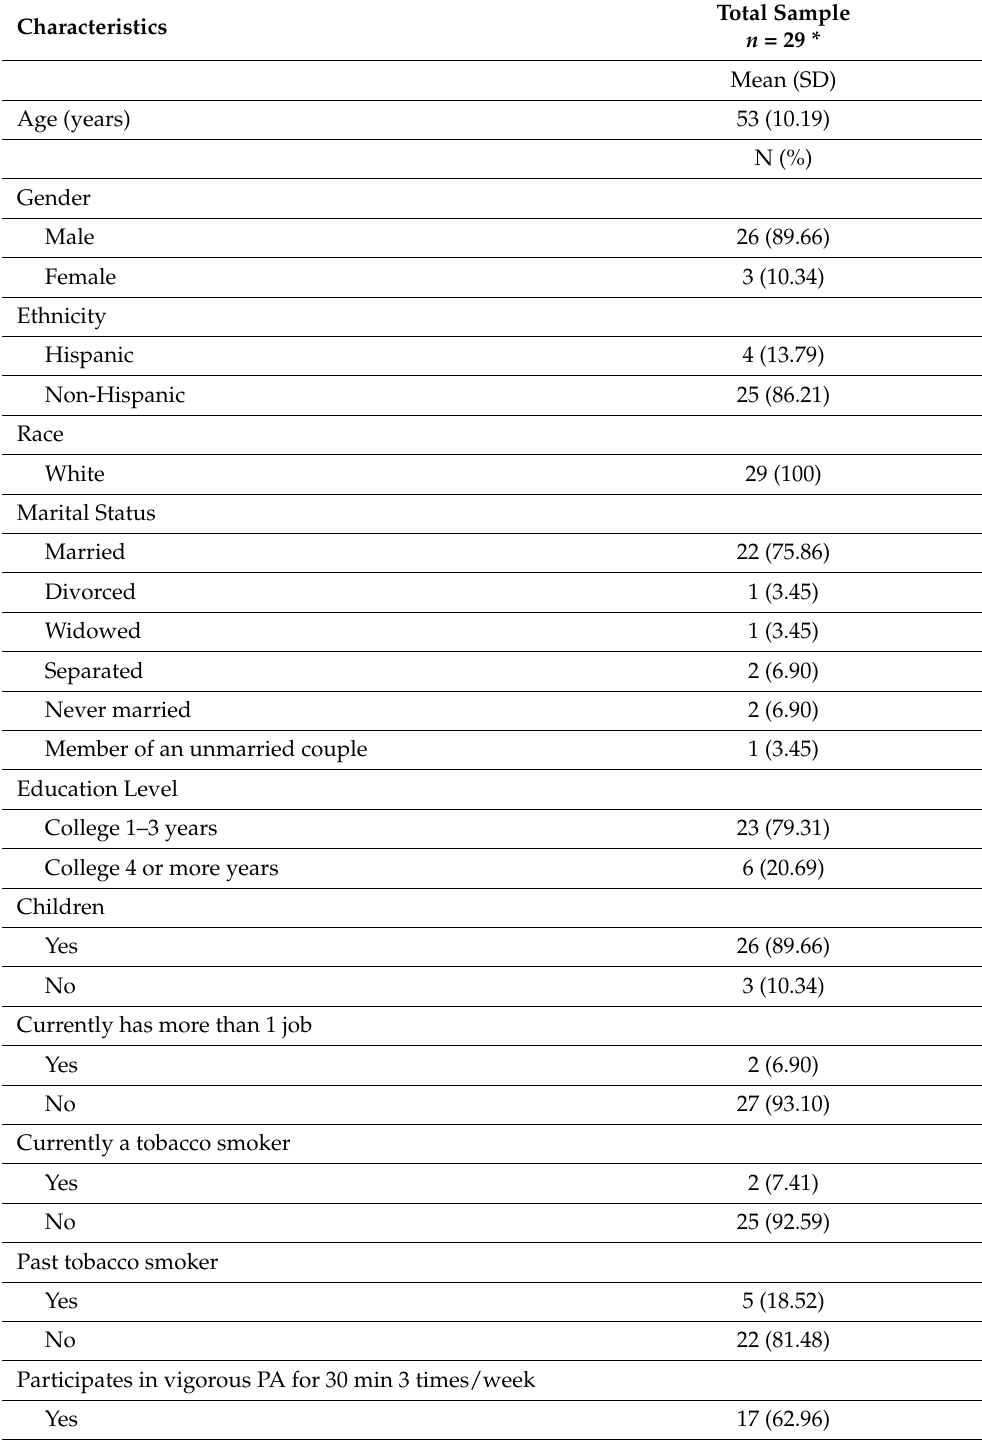
Table 1. Socio-demographic and cancer characteristics of firefighter cancer survivors participating in the firefighter cancer survivorship focus groups and